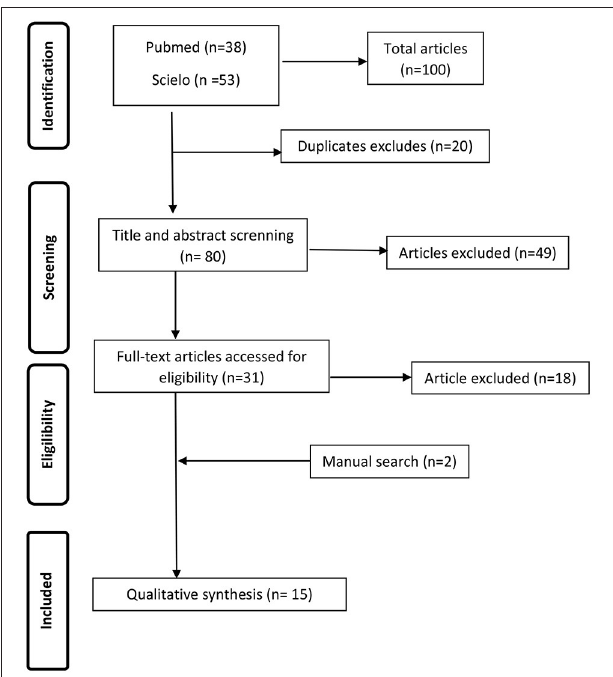
FIGURE 1 | Article